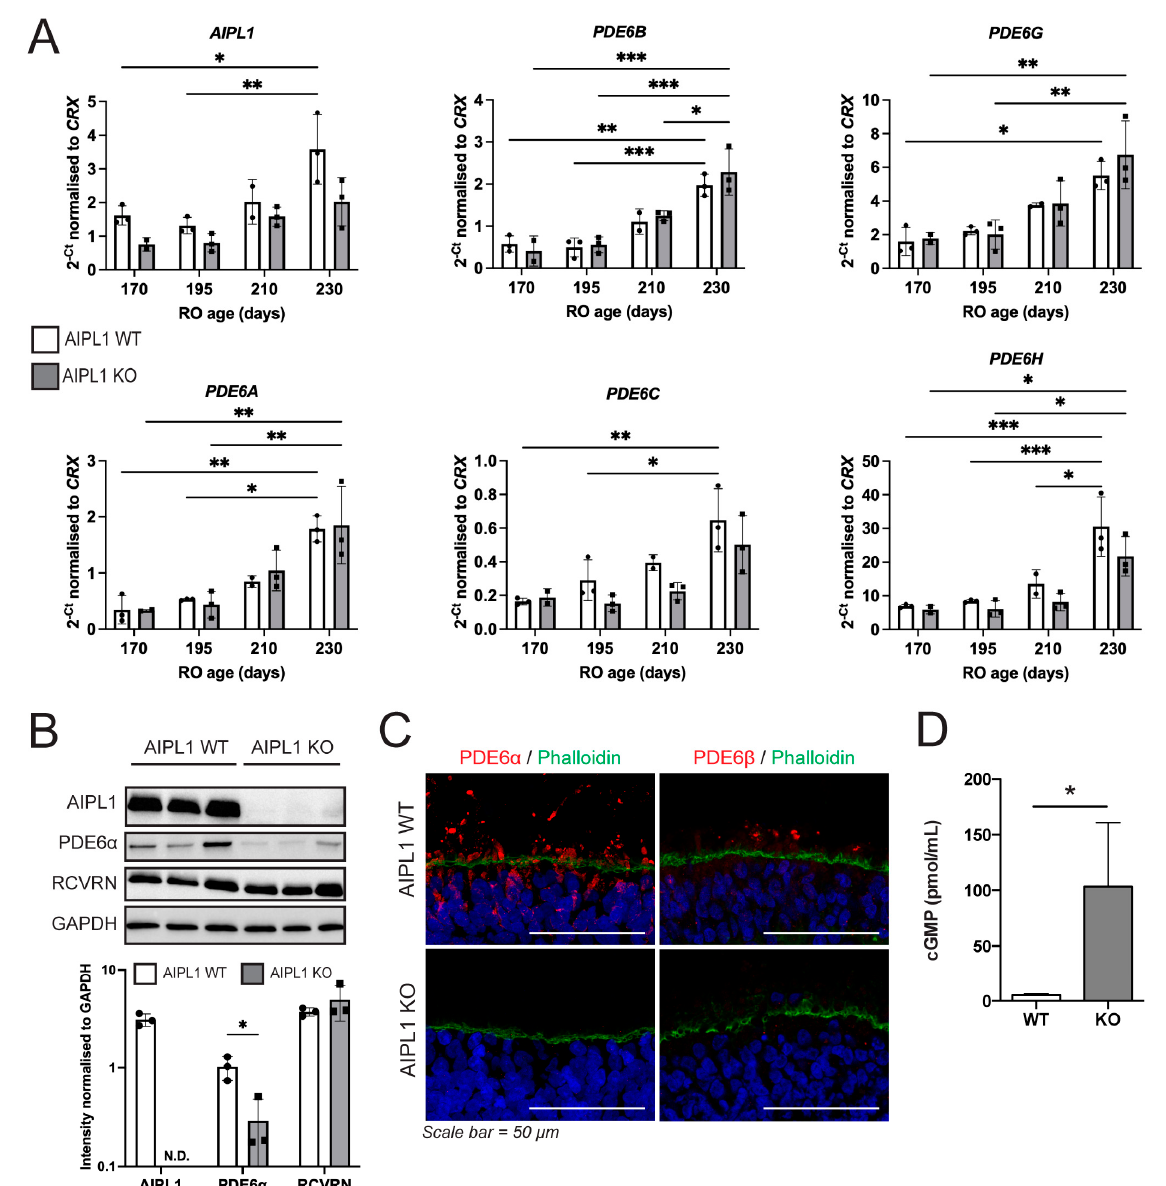
Figure 3. Retinal organoids derived from AIPL1 KO iPSC mimic early molecular features of LCA4 with no detectable PDE6 protein and elevated levels of cGMP. ( A ) qPCR of mature RO (W24-W33, D170-230) found minimal differences between AIPL1 WT and AIPL1 KO RO. RT-PCR for W8-W33 pooled samples is shown in Figure S4. Three biological replicates; mean +/ − SD. Significance calculated by 2-way ANOVA where *, **, *** indicates p < 0.05, 0.01 and 0.005, respectively. ( B ) Western blot of 25 µ g protein isolated from 3–6 pooled mature RO (W33, D230) for AIPL1, PDE6 α and recoverin (RCVRN), with GAPDH included as a loading control. Bands were quantified and normalised to GAPDH to show relative band intensity. Each lane contained protein from separate isolates. Three biological replicates; mean +/ − SD. Significance calculated by unpaired t test where * indicates p < 0.05. N.D. Not detected. ( C ) IF analysis of rod cGMP PDE6 α and PDE6 β (red) abundance in the ONL region of W30 (D210) RO identified no positive staining in AIPL1 KO RO. Scale bars = 50 µ m. ( D ) cGMP ELISA analysis of whole W33 (D230) RO showed elevated cGMP in AIPL1 KO RO compared to WT. Three biological replicates; mean +/ − SD. Significance calculated by unpaired t test where * indicates p <